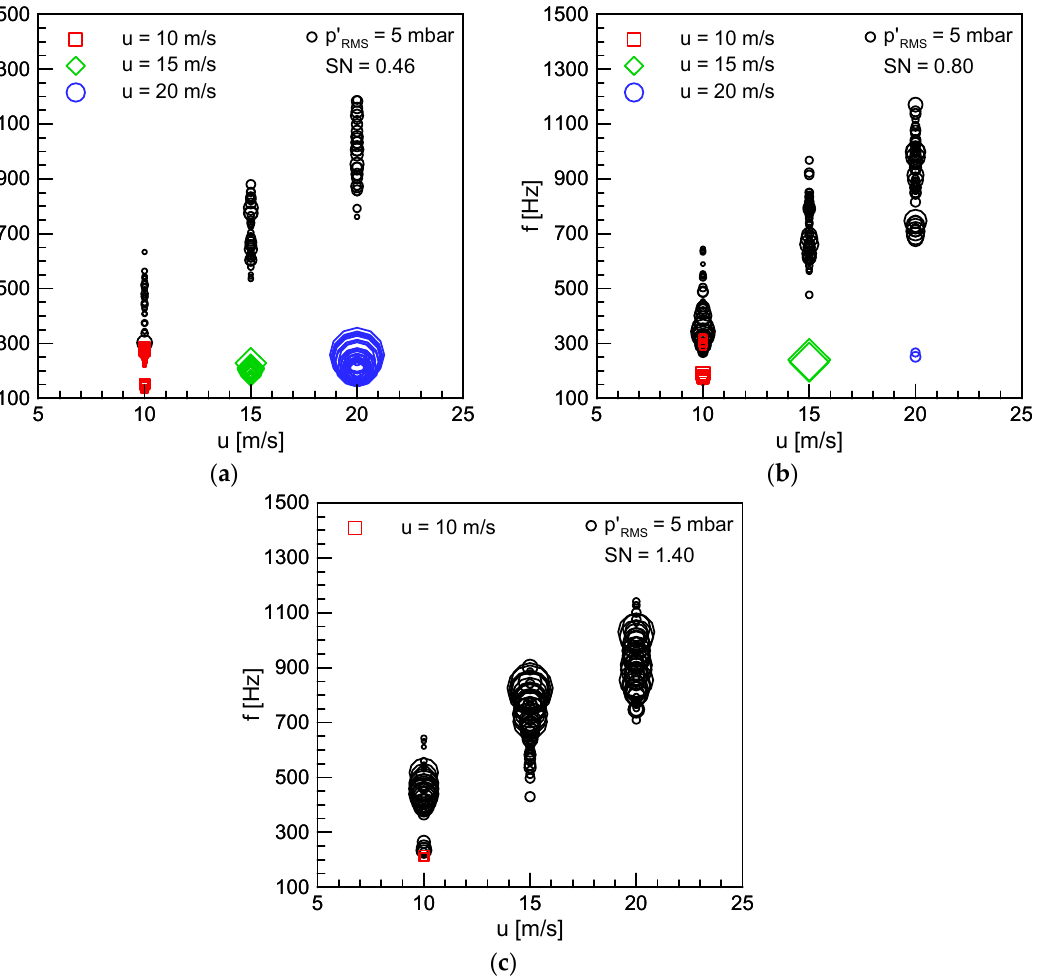
Figure 6. Dominant frequencies and their RMS values as a function of inlet mean velocity corresponding to the cases in Figure 4: ( a ) SN = 0.46, ( b ) SN = 0.80, and ( c ) SN = 1.40.